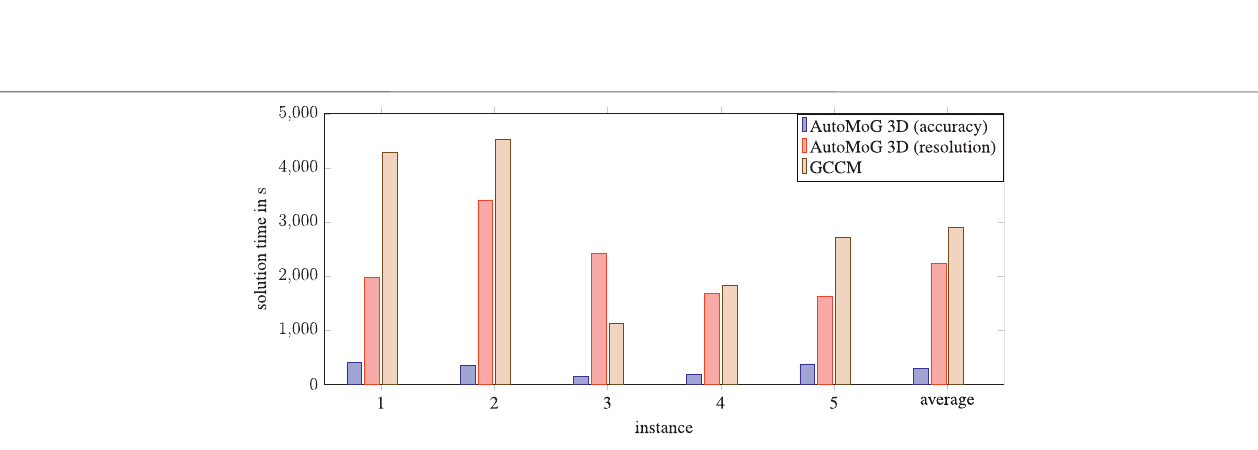
FIGURE 9 | Solution time to satisfy the optimality gap of 2% for all instances and all models except the MINLP model. The MINLP model did not ful fi ll the optimality gap in any instance at the time limit of 48 h. Therefore, there are no solution times for the MINLP model.